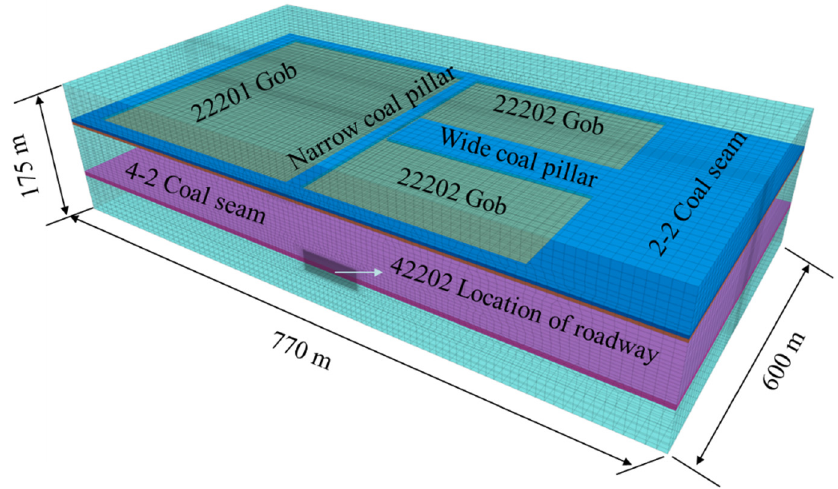
Figure 10. Global 3D numerical model.